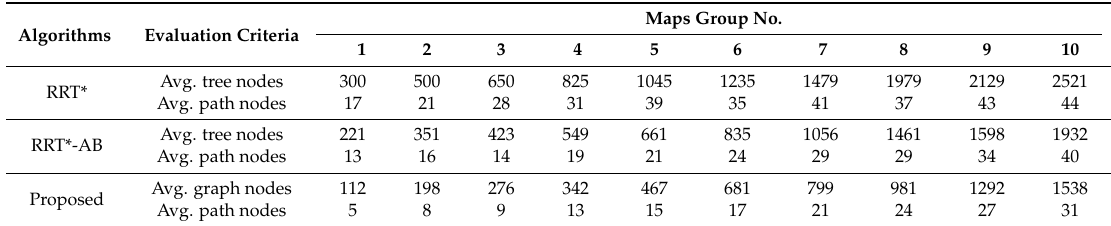
Table 4. Average graph/tree nodes and path nodes: proposed algorithm versus RRT* and